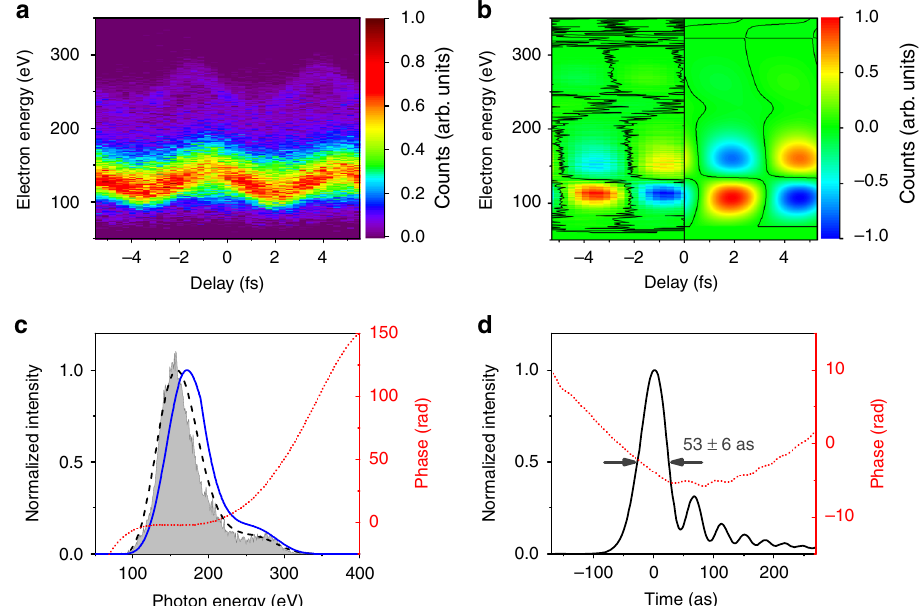
Fig. 3 PROOF retrieved 53 as soft X-ray pulse. a Photoelectron spectrogram as a function of temporal delay between the soft X-ray and the streaking IR pulses in the case of a 400-nm-thick tin fi lter. A negative delay corresponds to an earlier IR pulse arrival. b Filter I ω trace ( − 5 to 0 fs) from the spectrogram in a and the retrieved I ω trace (0 – 5 fs). c Experimentally recorded ( gray shade ) and PROOF-retrieved spectra ( black dash ) by adding helium photoionization potential (24.6 eV); corrected photon spectrum ( blue solid ), and spectrum phase ( red dot ) from PROOF. d Retrieved temporal intensity pro fi le and phase of the 53 as pulses